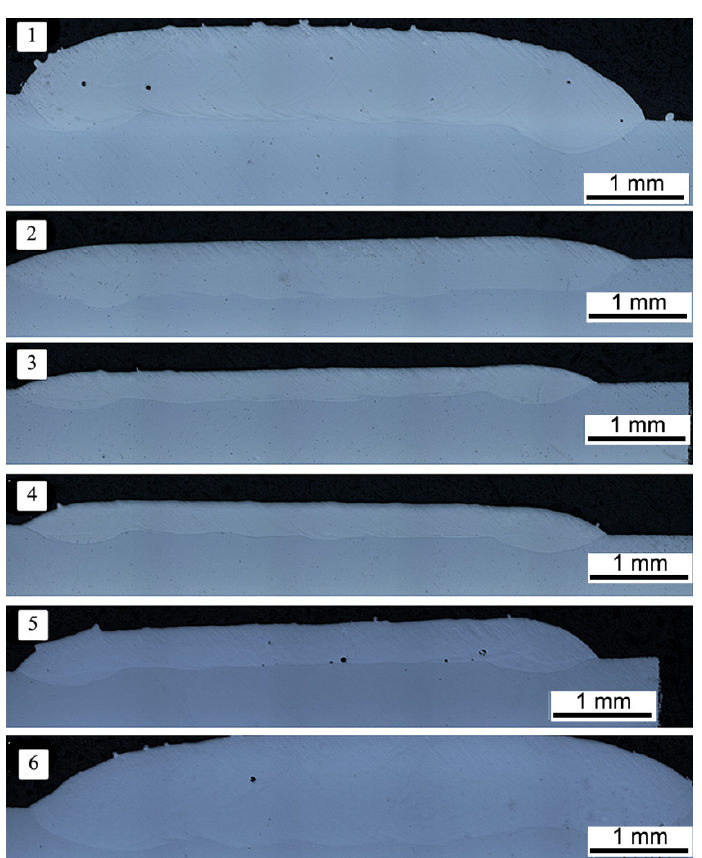
Figure 2. The cross section of Co-6 coatings deposited with different LENS process parameters.